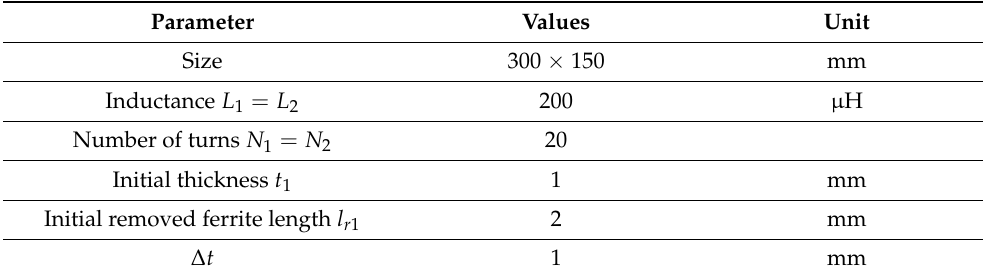
Table 4. Parameters for the ferrites of square-shaped coupler in a 3D simulation.